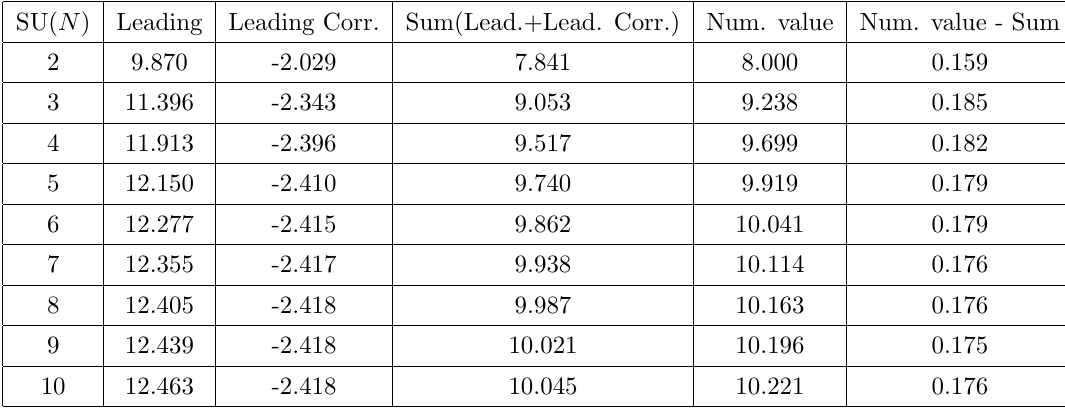
Table 8 . Comparison of N -ality 1 k -strings for SU(2